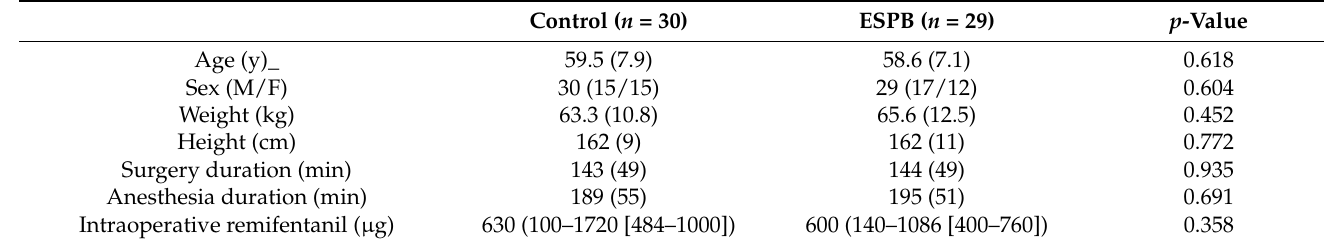
Table 1. Patient characteristics and perioperative clinical data.